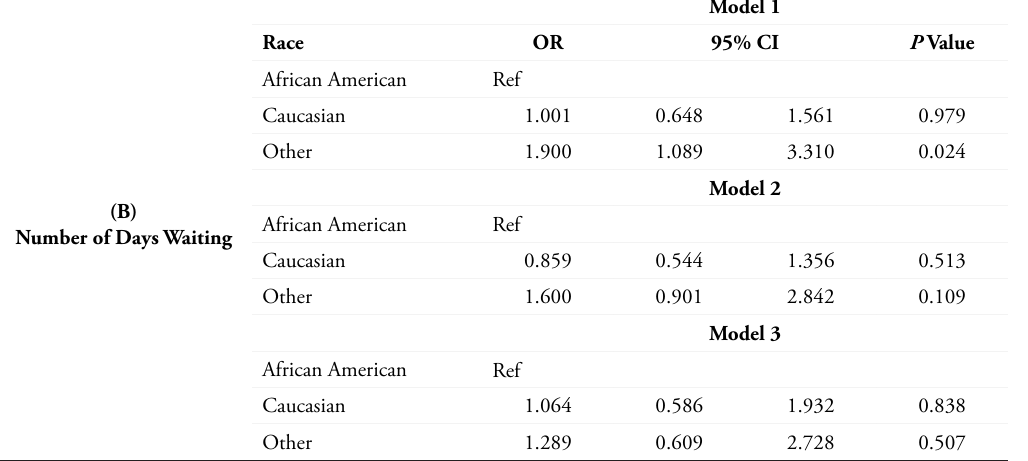
Table 6. Regression Results in Cincinnati CBSA by Race: (A) Planned Medication-Assisted Opioid Therapy (MAT), (B) Number of Days Waiting to Enter Treatment a